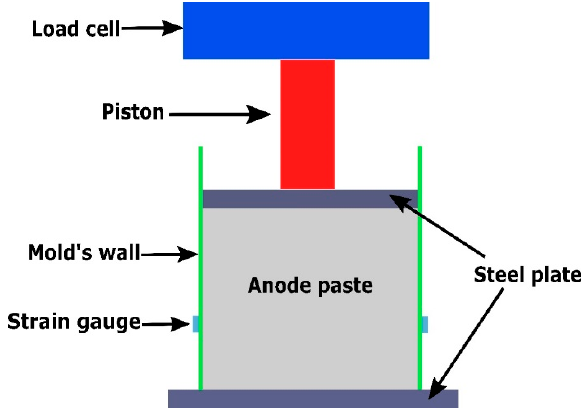
Figure 2. A schematic view of the experimental set-up.